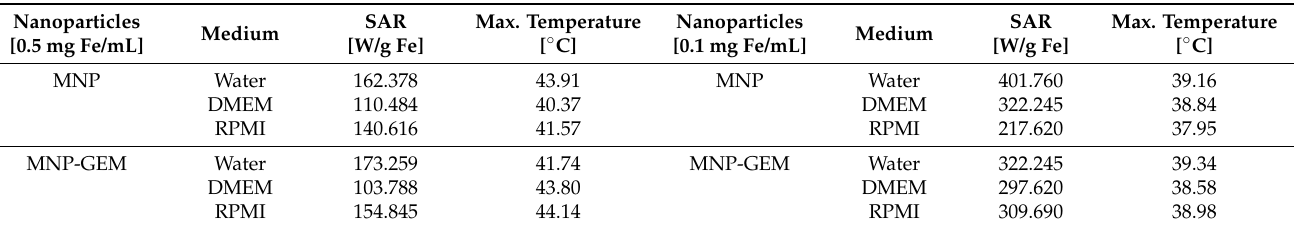
Table 2. SAR and maximum temperature values of MNP and MNP-GEM in different conditions after an AMF was applied (202 kHz, 29.9 mT, 20